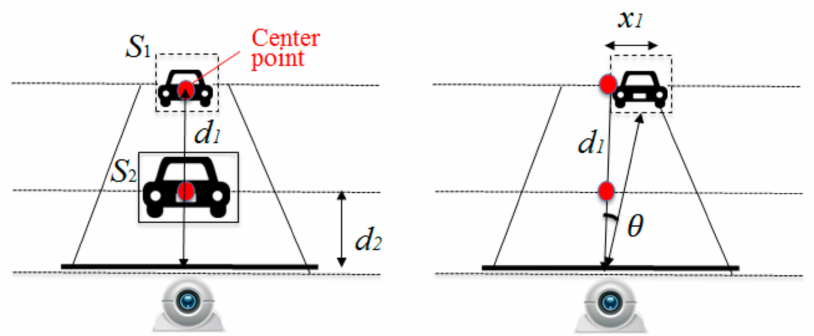
Figure 3. Parameters of the proposed calculations for the distance and the angle of the target